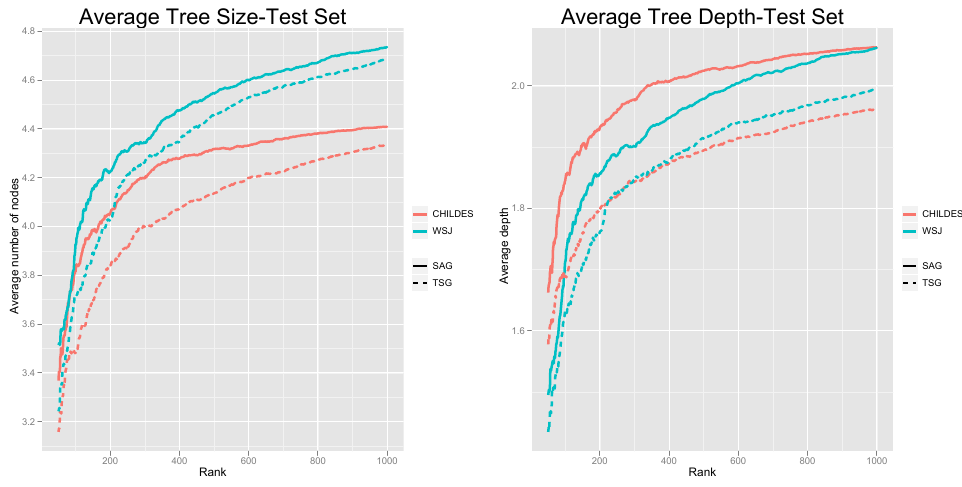
Figure 9: Complexity of stored tree fragments (generalization)